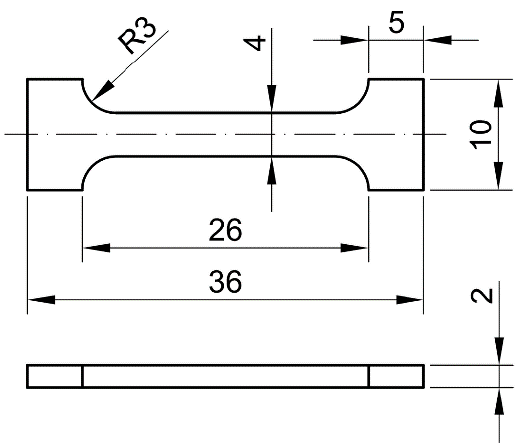
Figure 4. Drawing of the test bar used in tensile tests (dimensions are in millimeter).